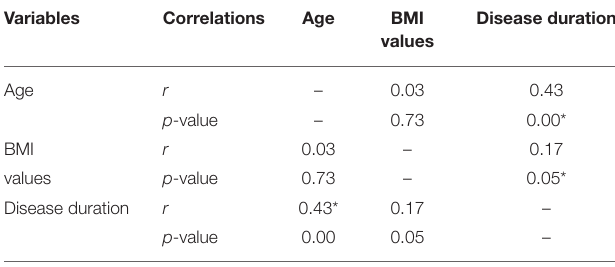
BMI, body mass index. * Statistically significant, Spearman’s rank correlation coefficient.